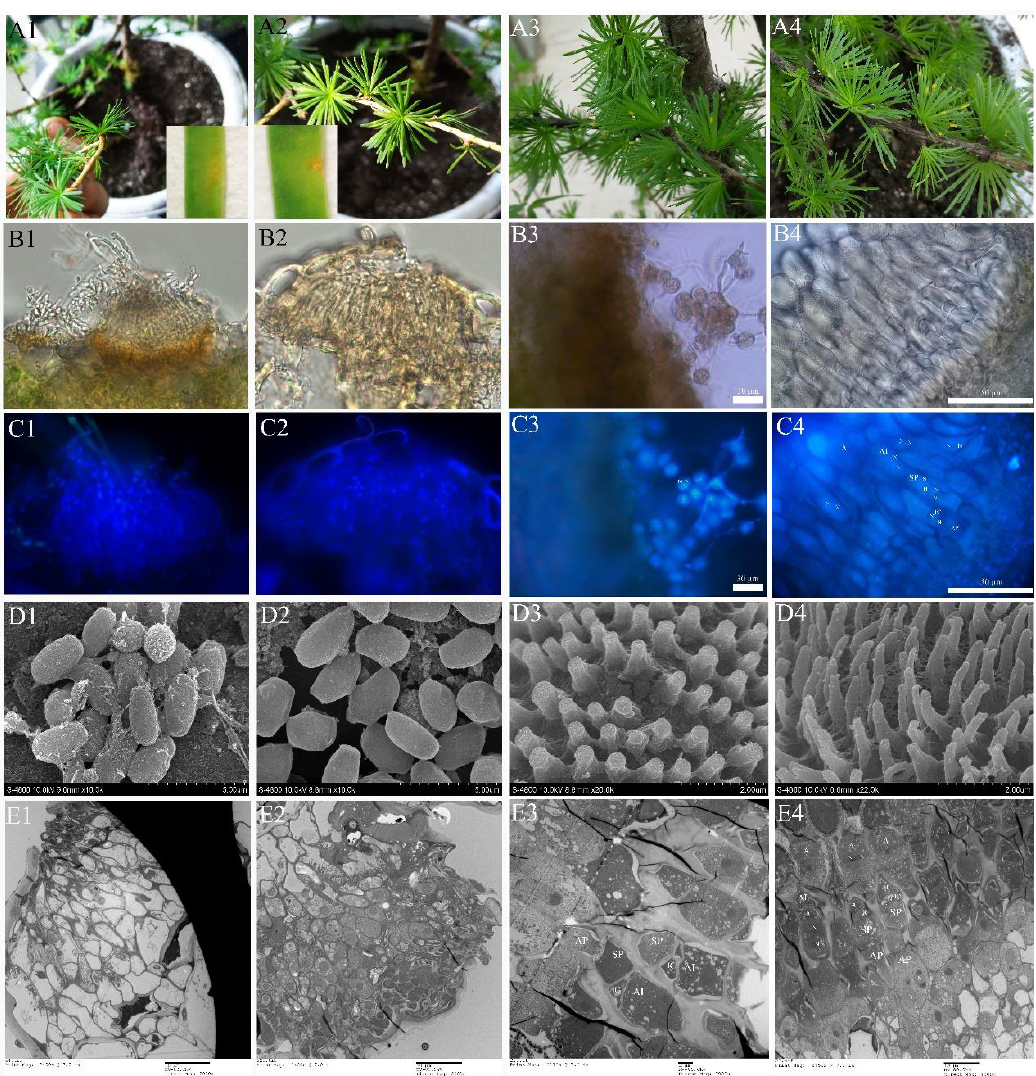
Figure 8. Ontogeny of pycniospora and aeciospora. ( A1 – E1 ), pycinospora stage of Mlp; ( A2 – E2 ), Pycinospora stage of Mmed; ( A3 – E3 ), Aeciospora stage of Mlp; ( A4 – E4 ), Aeciospora stage of Mmed; ( A1 , A2 ), Pycnia on the abaxial needle; ( B1 , C1 , B2 , C2 ), Pycnia under fluorescence microcopy; ( D1 , D2 ), Pycniospora under SEM; ( E1 , E2 ), Pycnia under TEM; ( A3 , A4 ), Aecium on the adaxial nee- dle; ( B3 , C3 ) and ( B4 , C4 ) are both aecium under light and fluorescence microcopy; ( D3 , D4 ) Verru- cose on the surface of aeciospora under SEM; ( E3 , E4 ), aecium under TEM; pycniospora (S), nucleus (N); conidiogenous cells (SP), interval cell (IC); aeciospora initial (AI); aeciosporophora (AP); aecio- spore